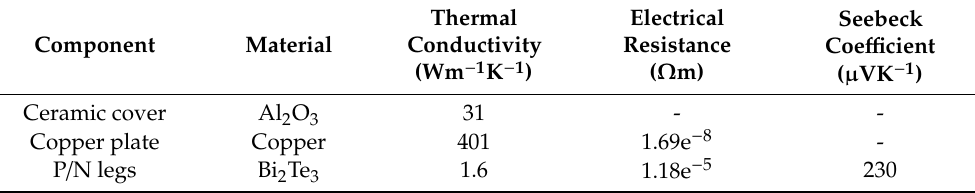
Figure 2. Numerical modeling of thermoelectric module for ANSYS simulation. Table 1. Physical properties of each component in TEG module package.